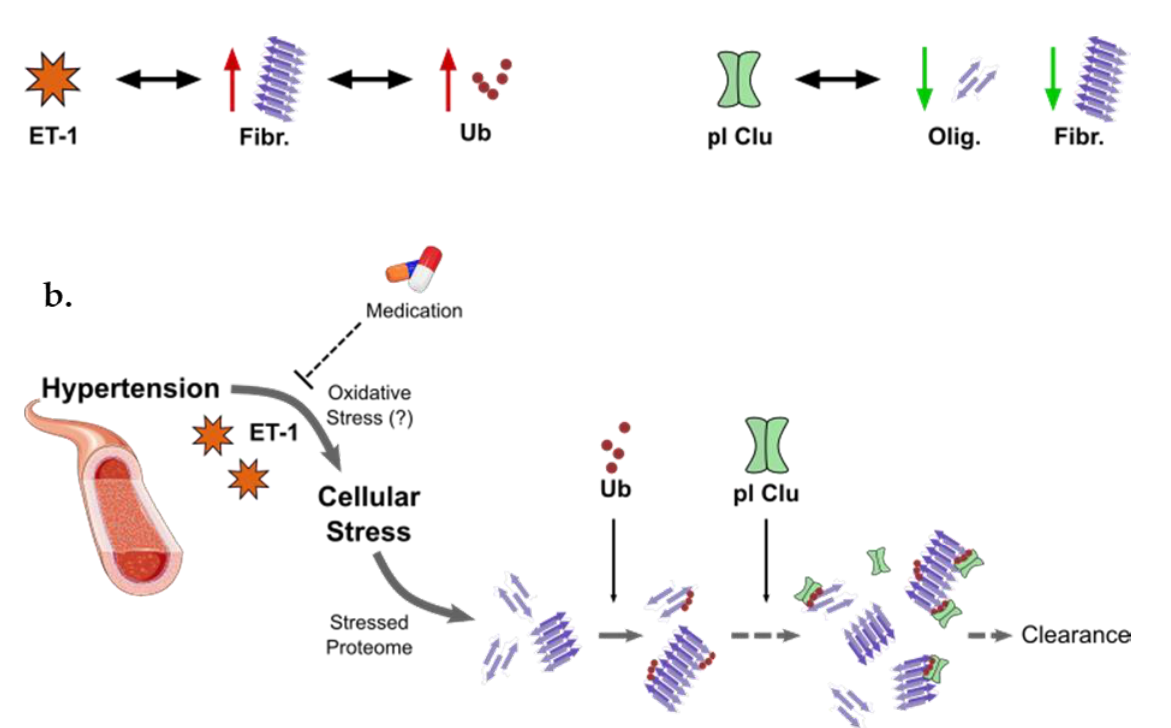
Figure 5. Proposed proteostasis response in individuals with controlled hypertension. ( a ) Associa- tions found between the levels of Endothelin 1 (ET-1), the proteostasis-associated proteins Ubiquitin (Ub) and plasma Clusterin (pl Clu), and Oligomers (Olig.) and Fibrils (Fibr.), in the hypertension group. ( b ) The proteostasis response to hypertension here proposed involves the subsequential action of Ubiquitin and Clusterin as a coping mechanism to restore proteome balance. In this, Ubiquitin first tags oligomers and fibrils that continuously arise from endothelial dysfunction, and these tagged aggregates are subsequently targeted by the plasma chaperone Clusterin, to prevent further aggregation and promote their clearance. (Image source for blood vessel: Servier Medical